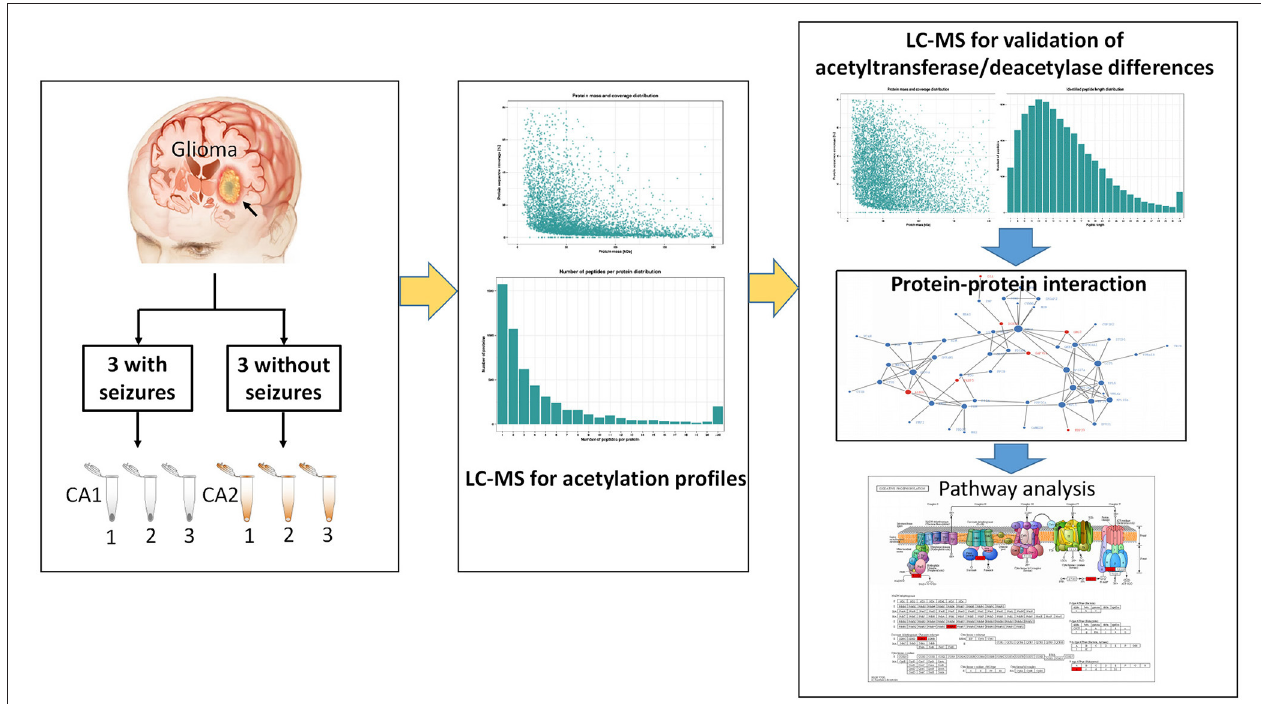
FIGURE 1 | The workflow of the